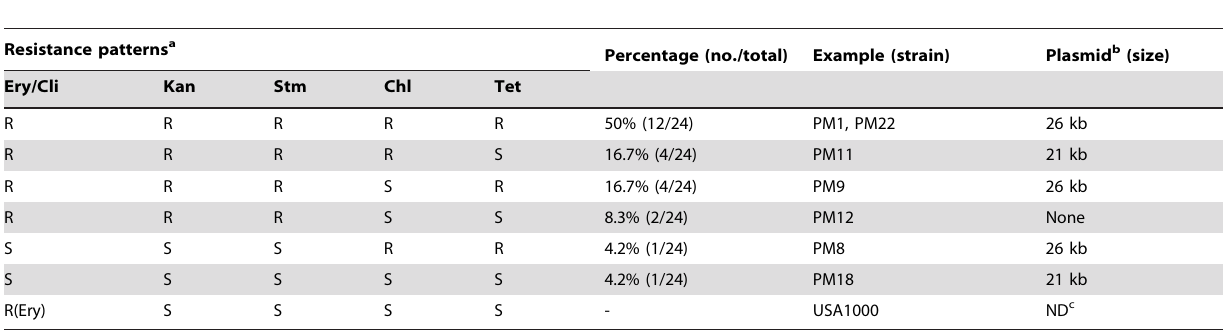
Table 1. Resistance patterns of ST59 CA-MRSA strains isolated in Taiwan, compared to ST59 MRSA USA1000.